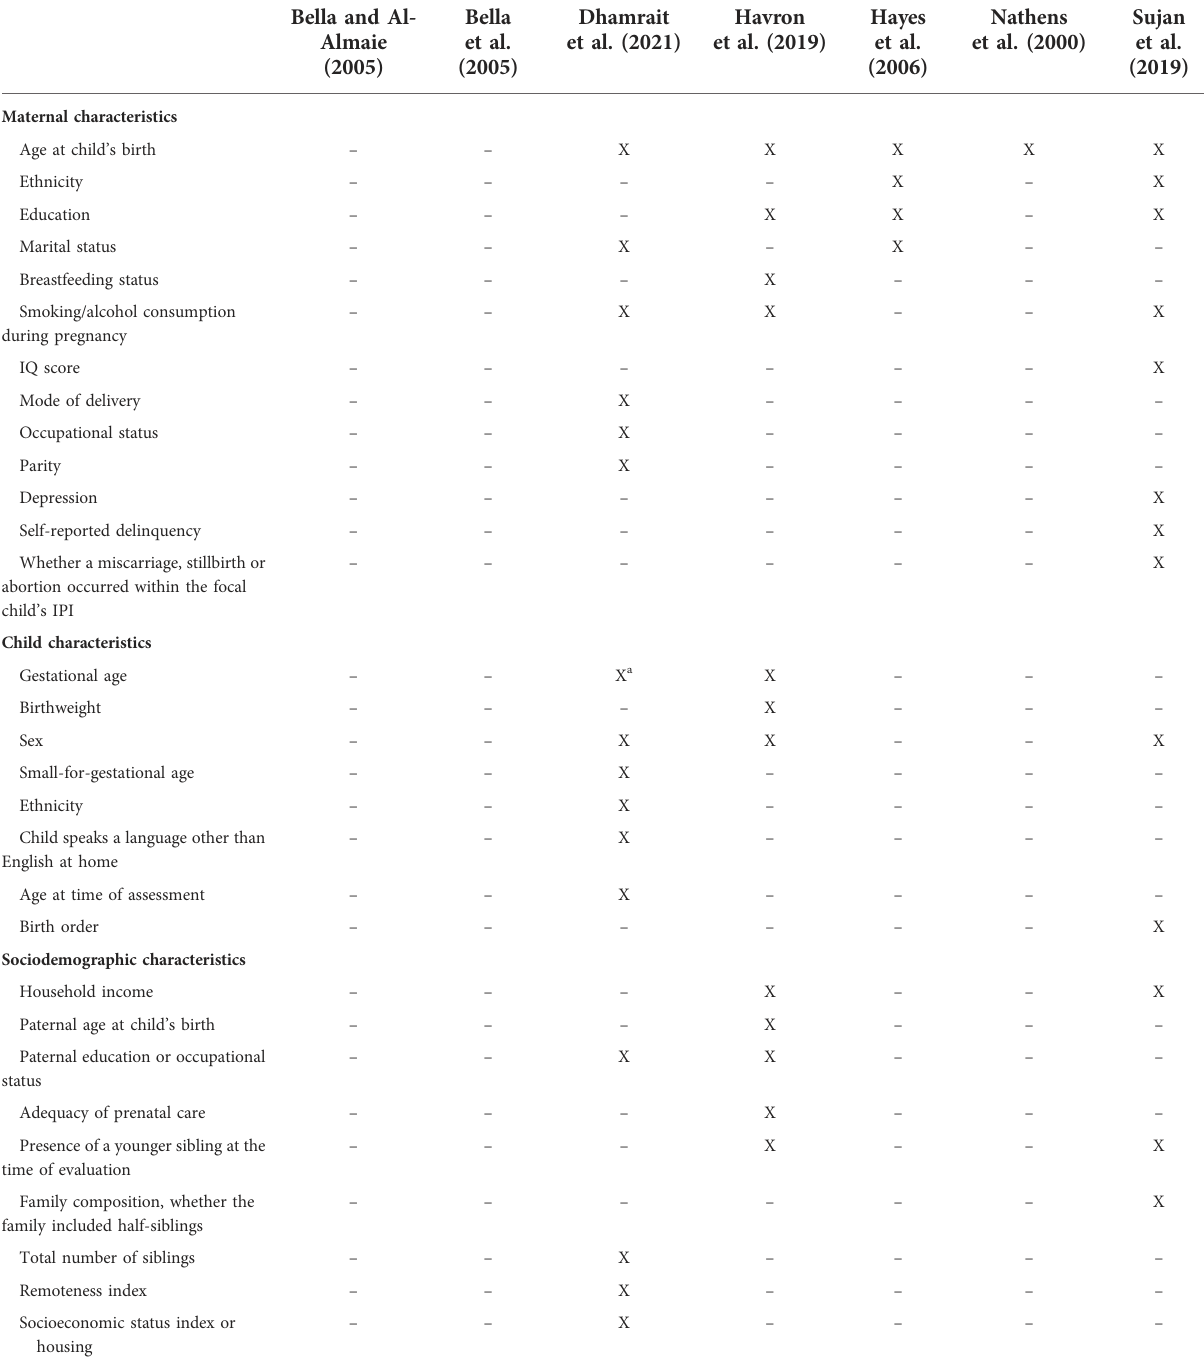
TABLE 2 Adjustment variables listed in original